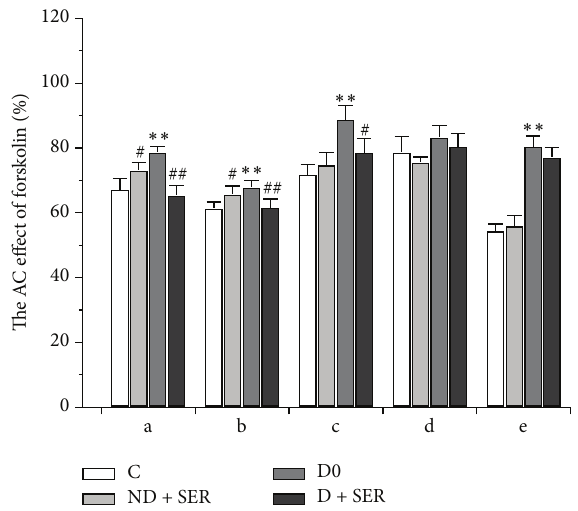
Figure 6: The inhibiting effects of hormones on forskolin- stimulated AC activity in the brain of diabetic and nondiabetic rats with and without IS treatment. a—5-NOT, b—5-MeO-DMT, c— bromocriptine, d—norepinephrine (all were used at a concentration of 10 −5 M), and e—somatostatin-14 (10 −6 V ). The AC stimulating effect of forskolin (10 −5 M) in the absence of hormone is taken as 100%.ThedataarepresentedasM ± SD.( ∗∗ )Thedifferencebetween Groups C0 and D0 is significant at 𝑃 < 0 . 0001, and (#, ##) the differencebetweenGroupsC0andND+SERorbetweenGroupsD0 and D + SER is significant at 𝑃 < 0 . 05 and 𝑃 < 0 . 0001, respectively.